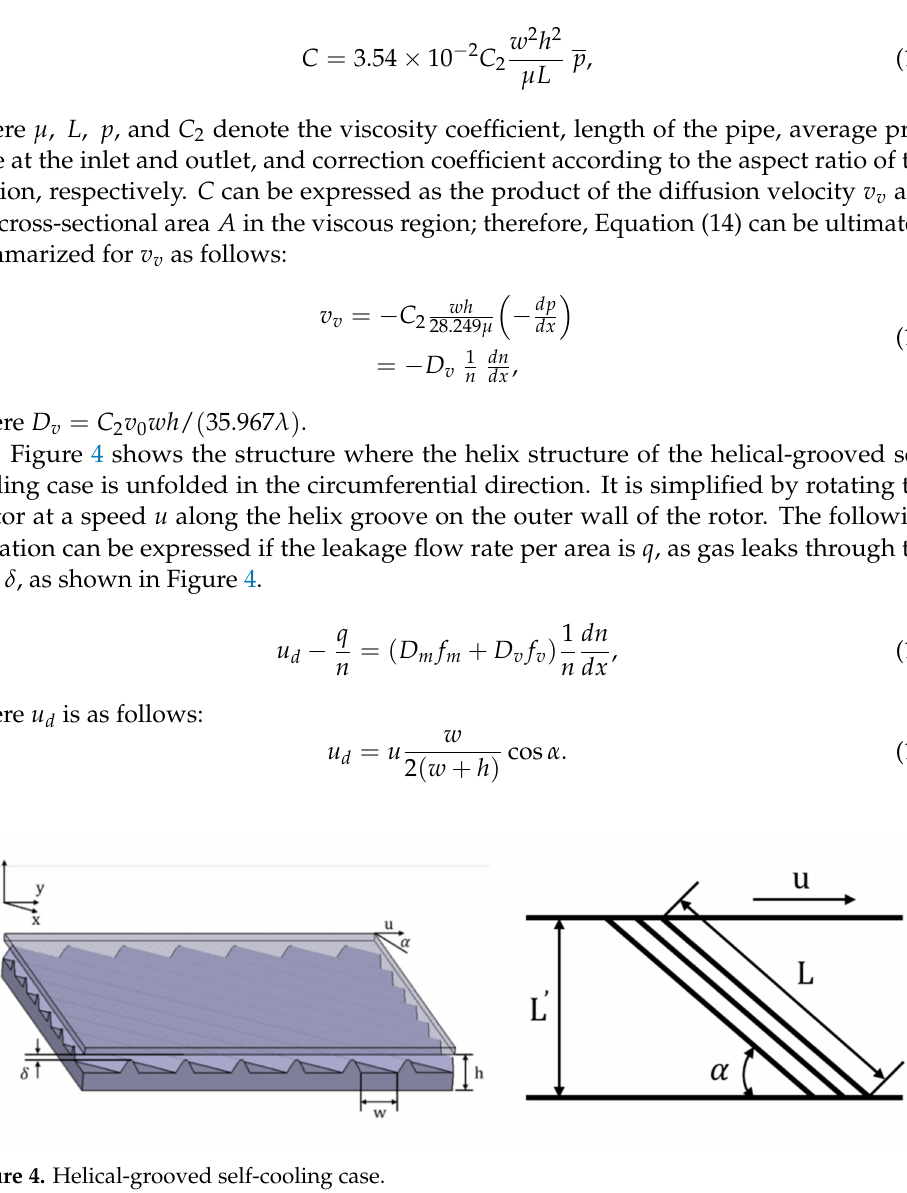
Figure 4. Helical-grooved self-cooling